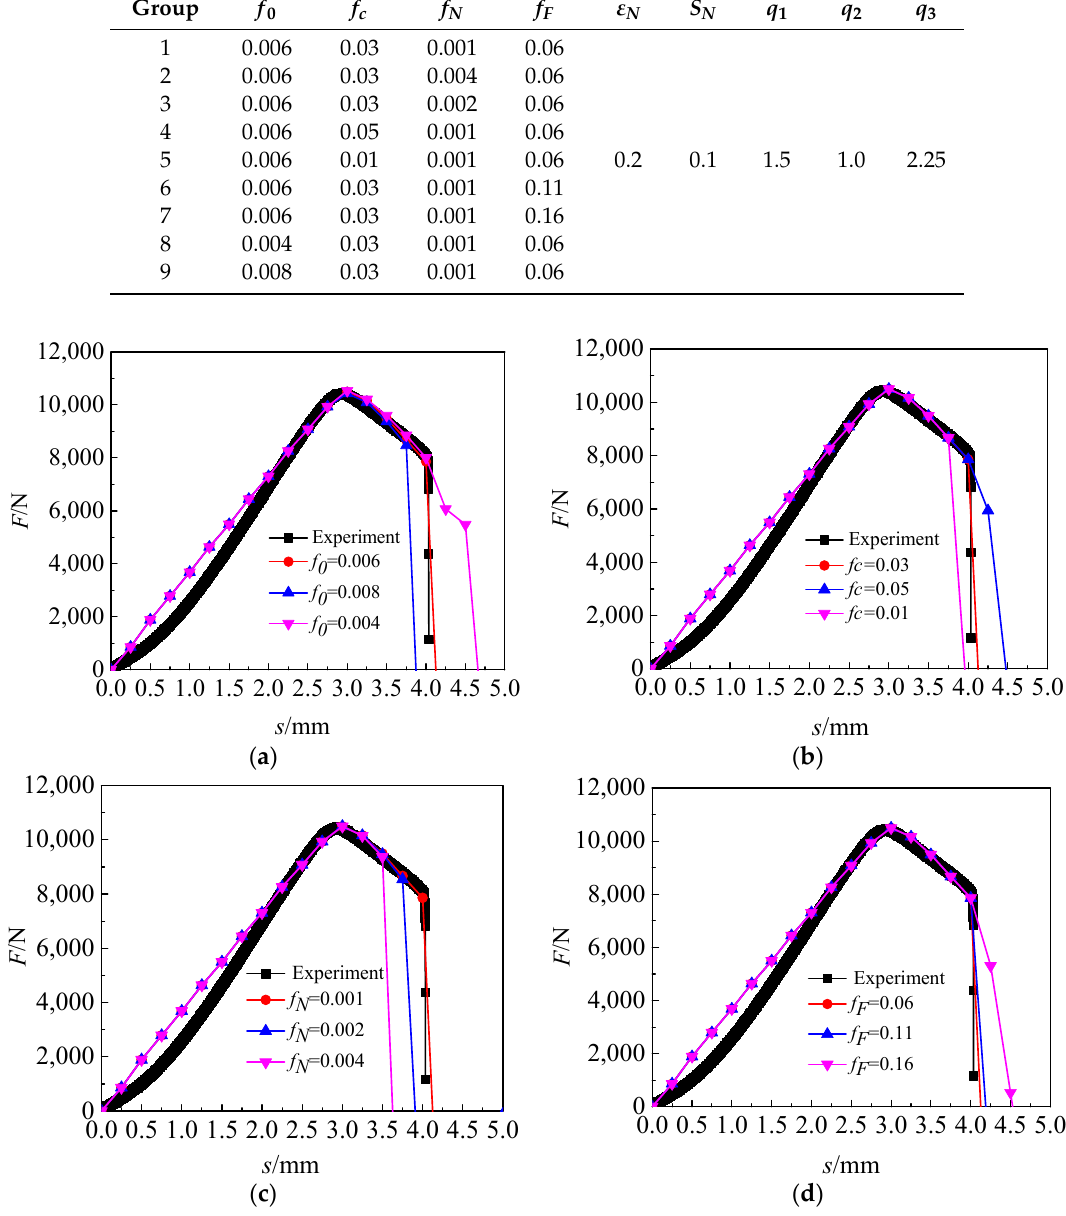
Figure 2. Influence of damage parameters on load-displacement ( F - s ) curves ( a ) change void volume fraction ( f 0 ); ( b ) change critical void volume fraction ( f c ); ( c ) change volume fraction of potential nucleated voids ( f N ); ( d ) change void volume fraction at the final failure ( f F ).